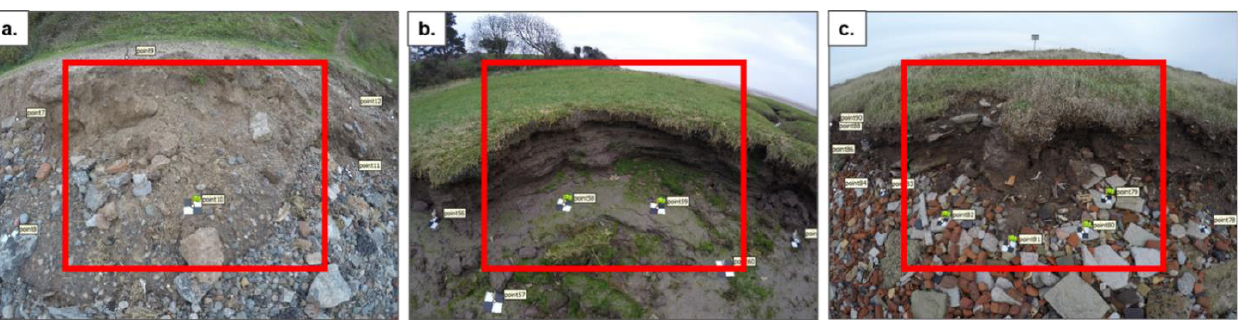
Figure 4. Red squares highlight the estimated central portion of the image were Agifsoft Photoscan markers should be placed on GCPs: ( a ) Thurstaston, ( b ) Silverdale and ( c ) Crosby.